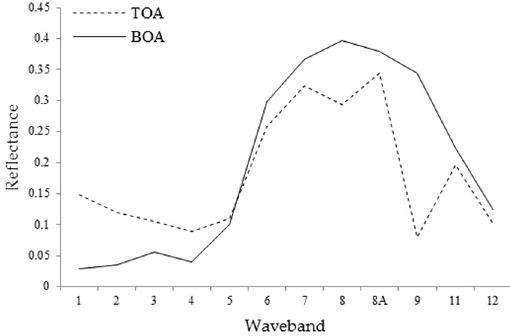
Figure 2. Comparison of vegetation reflectance curves between the original image and atmospheric correction image.